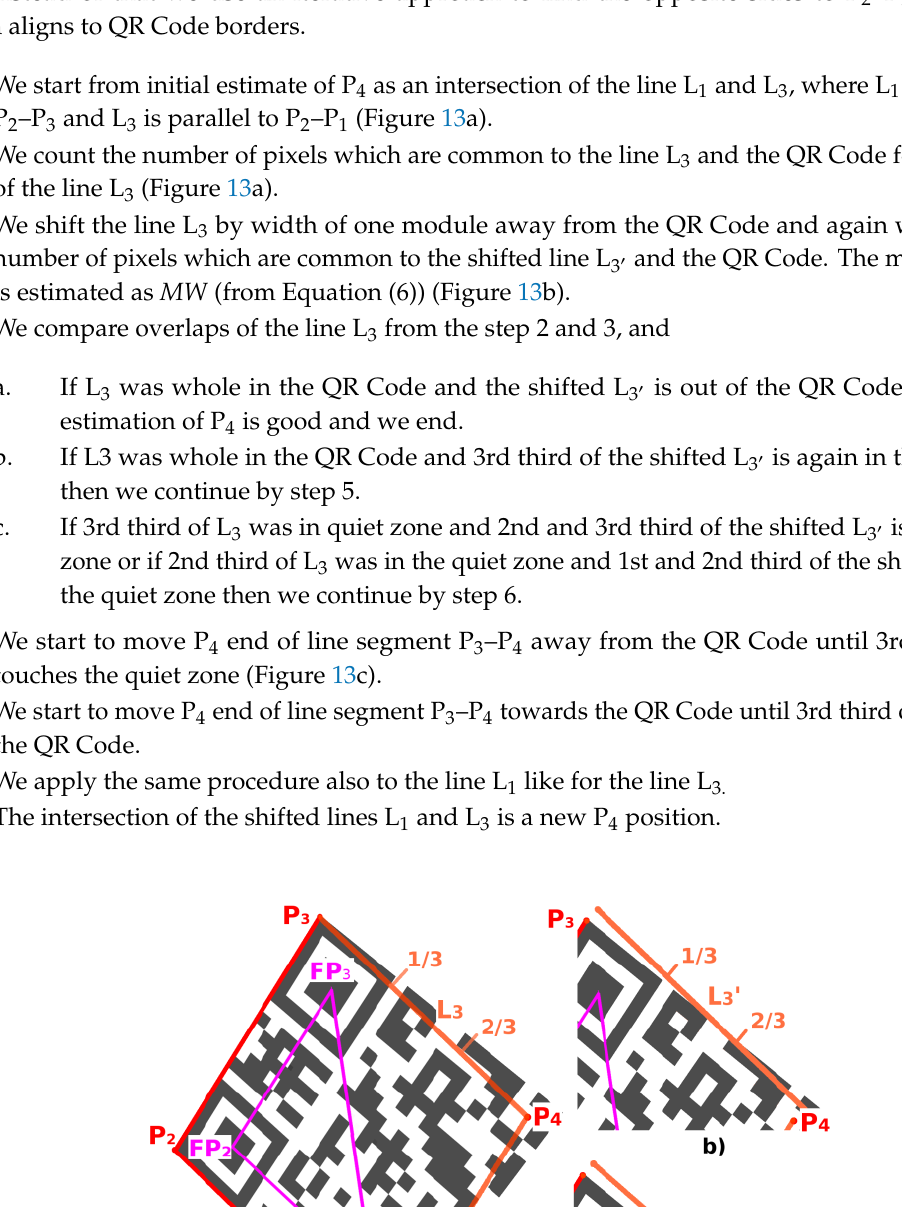
Figure 14. Perspective transformation. Using equations [21]: 1    hygx cbyax u , 1    hygx feydx v